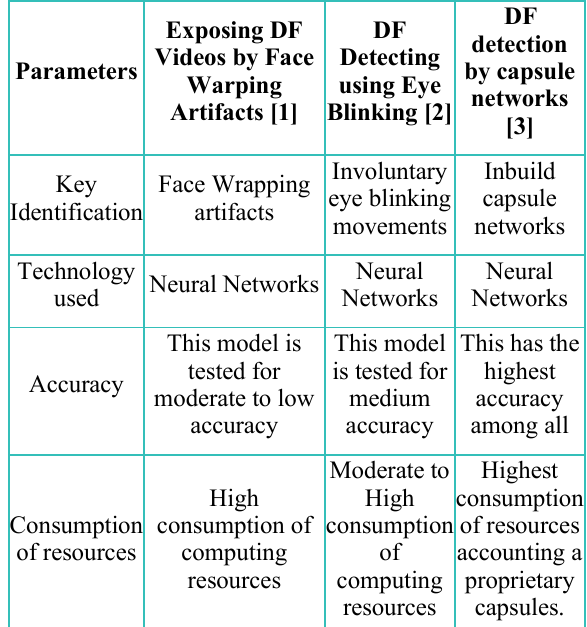
Fig 3. Graph showing the count of papers published from 2016-2021 based on deepfake project [18-20] Our approach is designed to be trained on datasets that are both noiseless and real-time. Comparison between the different papers is shown in Table 1 based on the key parameters that distinguish each project. Table 1. Comparison Between Different